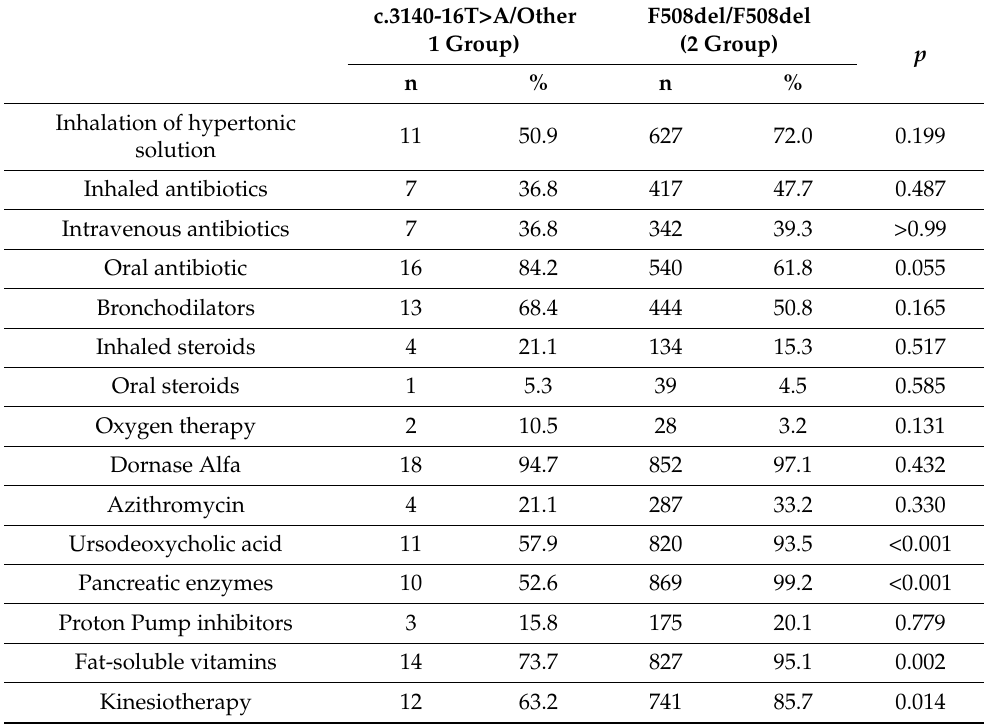
Table 5. Therapy for patients with cystic fibrosis with different genotypes.